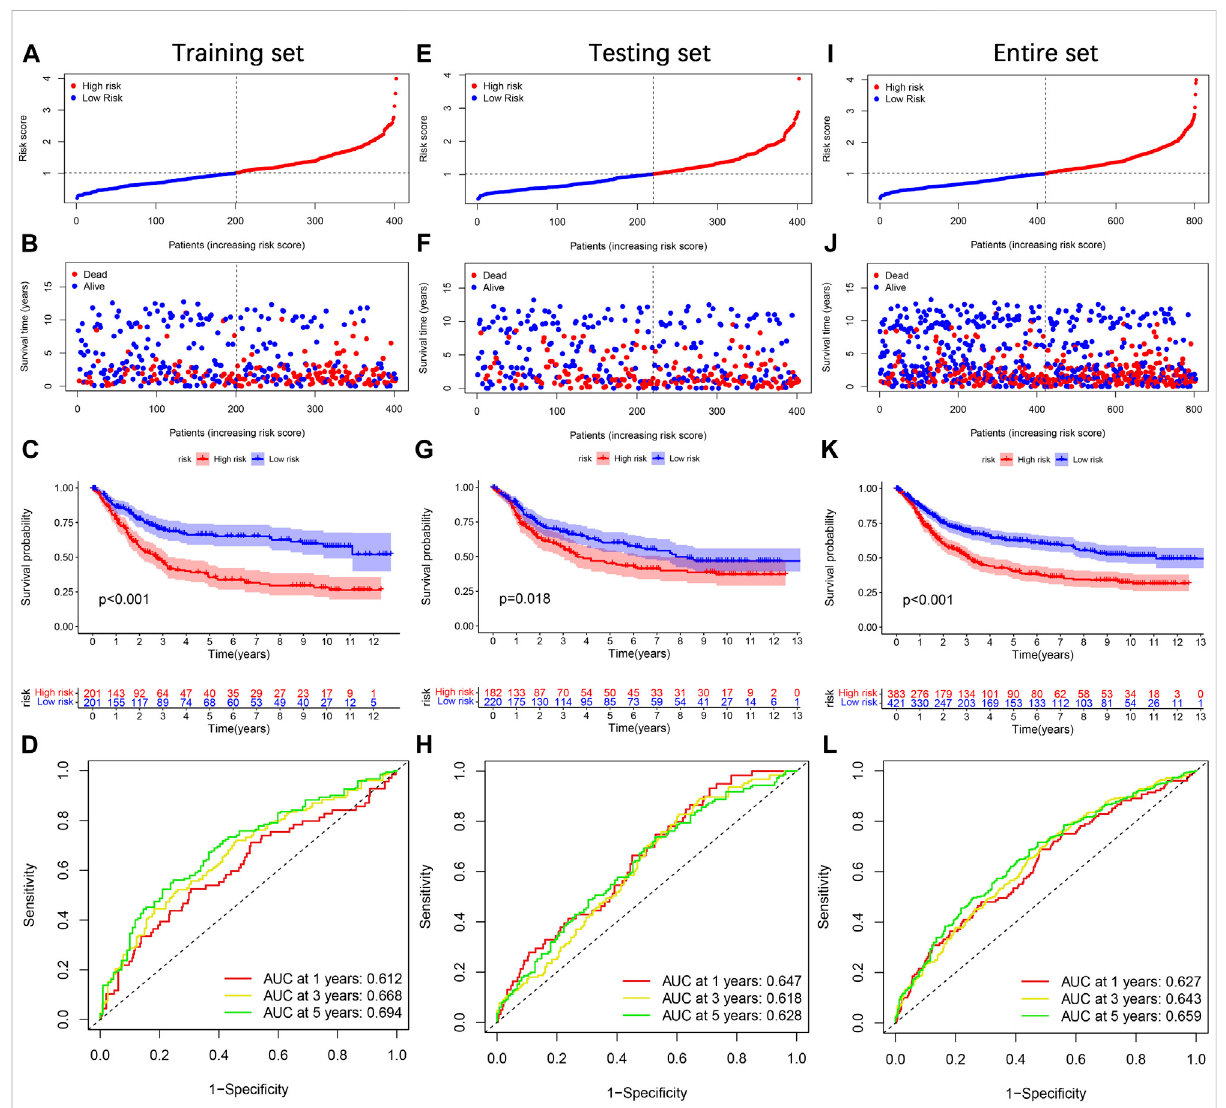
FIGURE 6 Prognosis value of the TGF- β cluster-related DEGs prognostic model. (A) The distribution of risk score, (B) survival status, (C) Kaplan – Meier survival curves, (D) the 1-, 3-, and 5-year ROC curves. (E – L) The validation sets, including the testing set and the entire set, were analyzed